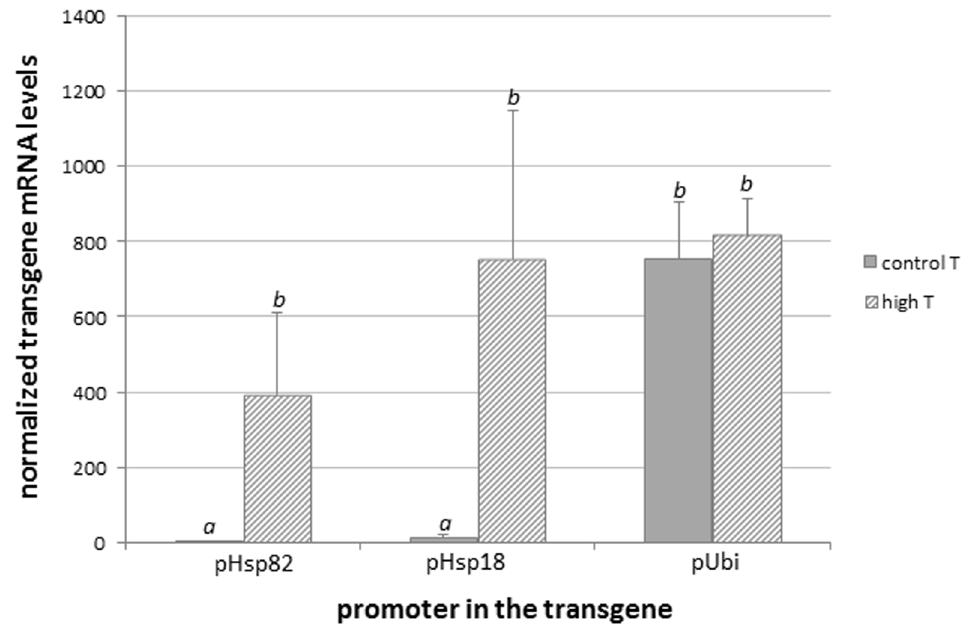
Figure 4. Transgene mRNA expression levels in leaves of GM rice plants in which the reporter dsred-tag54 was regulated by three different promoters, pHsp82, pHsp18 and pUbi. Three independent events were analyzed carrying every construct. For each event, T 1 seeds were germinated under control conditions and sets of eight plants at the V2 stage were either subjected to 42 u C for 2 h, or not, and their leaves were individually sampled. Sets of five plants harboring the transgene (i.e. giving positive transgene signal using the Phire Plant kit) were collectively analyzed by RT-qPCR targeting the sequence encoding DsRed-tag54, and normalized against ef1 a . Mean and SD values corresponding to each promoter are shown. Letters indicate statistically different transgene mRNA values (One-way ANOVA, Tukey’s b posttest a , 0.05).